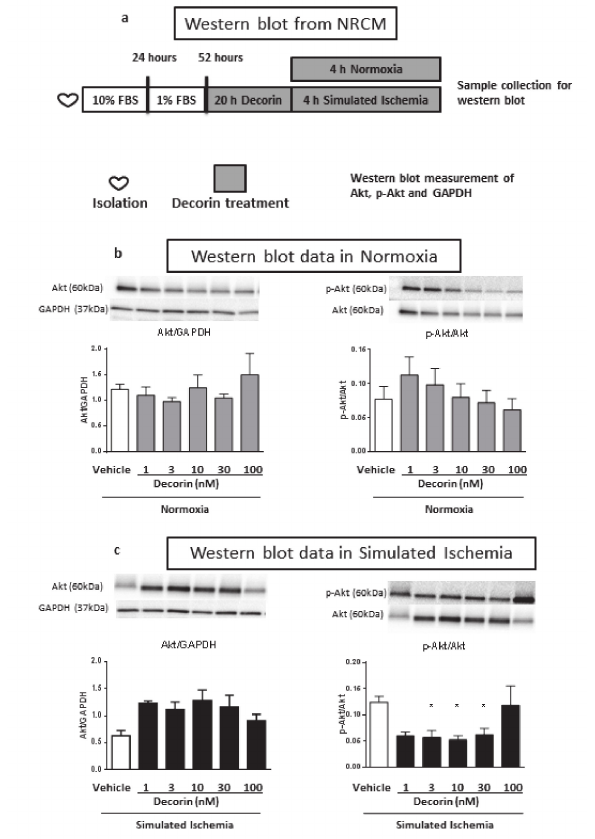
Figure 5. The e ff ect of 1, 3, 10, 30 and 100 nM decorin on Akt, p-Akt protein level in NRCMs exposed to SI / R or Normoxia. ( a ) Experimental protocol of western blot sample collection. ( b ) Akt / GAPDH expression ratio and p-Akt / Akt ratio in Normoxic conditions. ( c ) Akt / GAPDH expression ratio and p-Akt / Akt ratio in SI / R. Representative western blot images are included above quantified column diagram. Data are presented as mean ± S.E.M., One-Way ANOVA, Fisher post hoc test, * p < 0.05 vs. normoxia ( n =